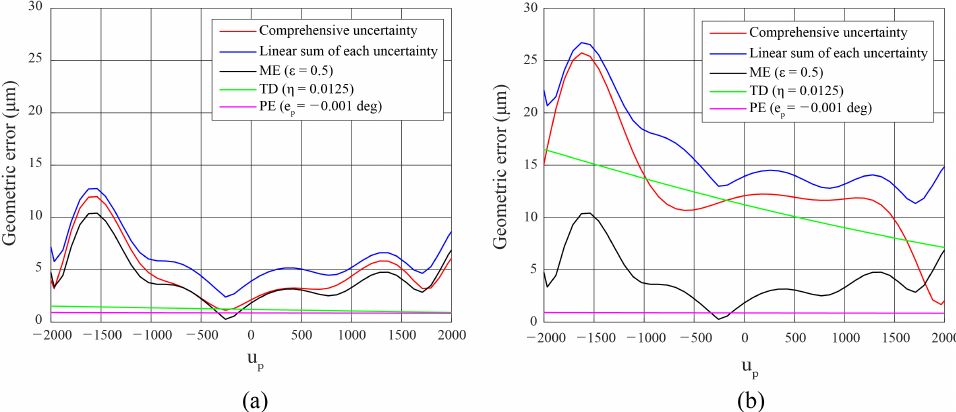
Figure 20. Size of geometric error of ( a ) steel and ( b ) plastic gears (Comprehensive uncertainty: (cid:101) = 0.5, η = 0.0125, e p = − 0.001 deg, ME : (cid:101) = 0.5, η = 0, e p = 0 deg, TD : (cid:101) = 0, η = 0.0125, e p = 0 deg, PE : (cid:101) = 0, η = 0, e p = − 0.001 deg, ME + TD : (cid:101) = 0.5, η = 0.0125, e p = 0